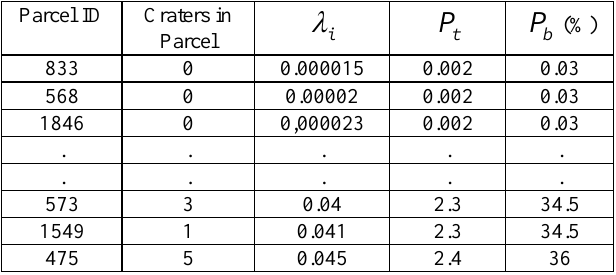
Table 1. calculation of per parcel dud properties at 15% unfused quota 2.2. Optimum Parcel